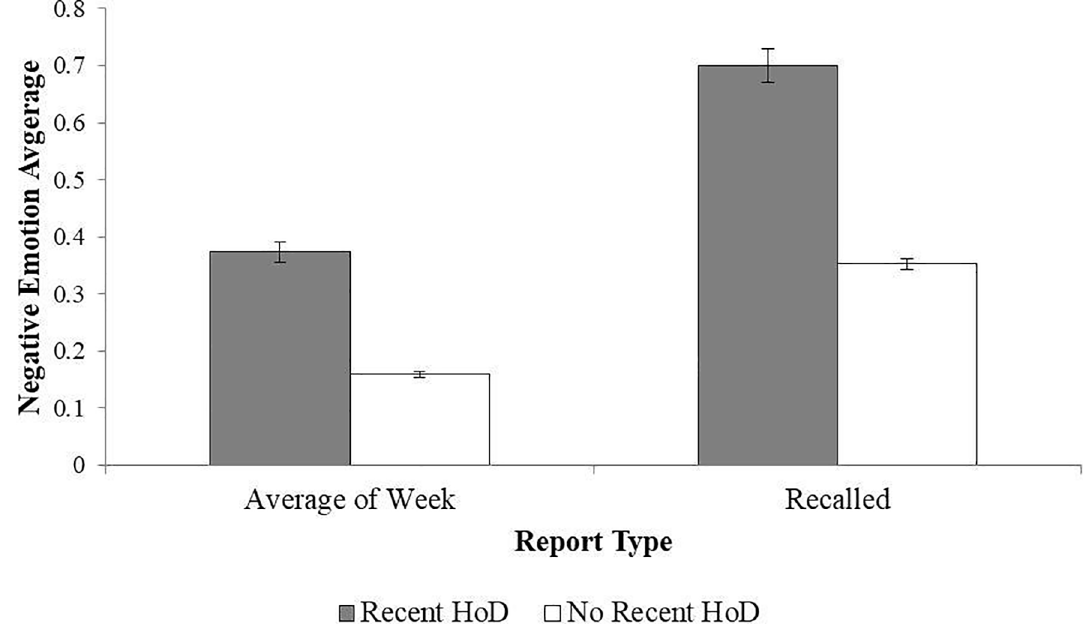
Fig 1. Negative emotion by recent history of depression. Note . Error bars represent standard error values. HoD = History of Depression. The model is adjusted for gender and evaluated at the following values: Age = 56.67, Education = 7.39.